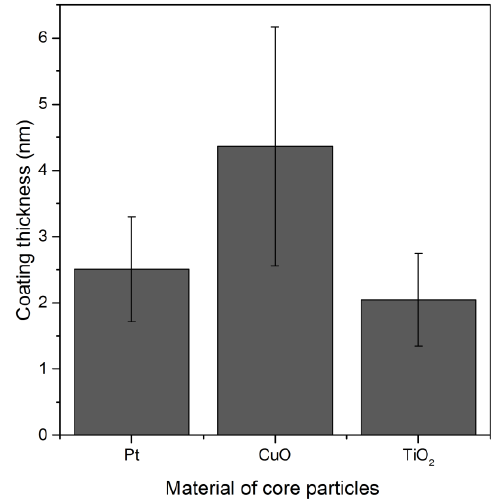
Figure 9. Influence of the particle material on the coating thickness from TEM analysis at a given TEOS concentration of 0.7 ppmv for t Reaction = 83 s.